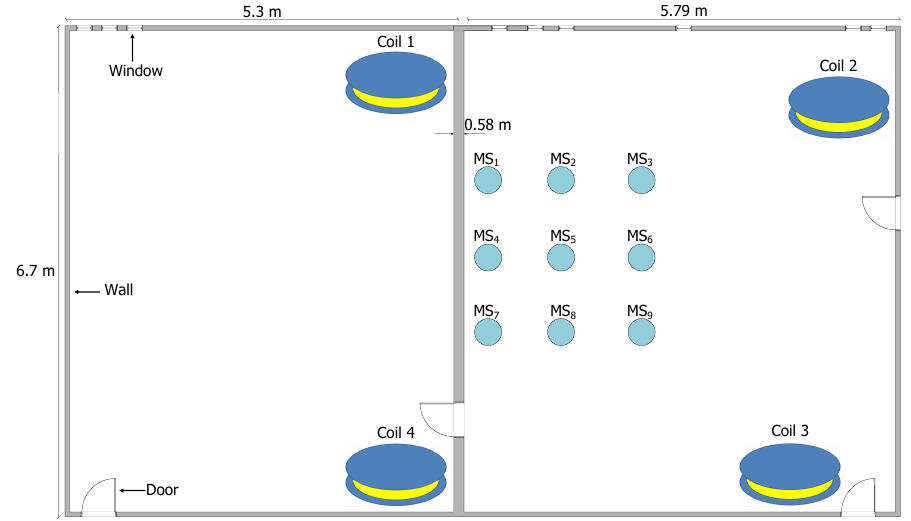
Figure 14. Experimental setup for position measures between various MSs and four